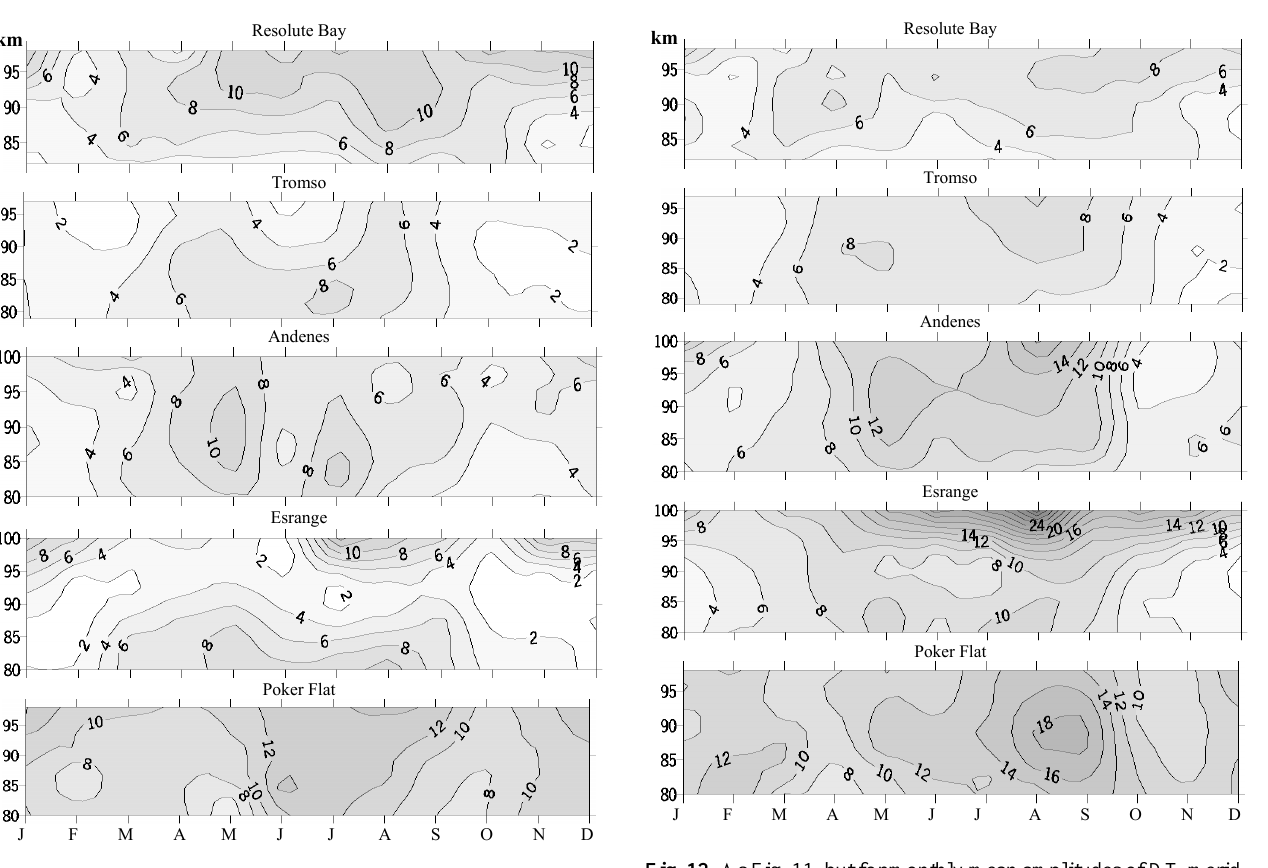
Fig. 11. As Fig. 7, but for monthly mean amplitudes of DT, zonal component.